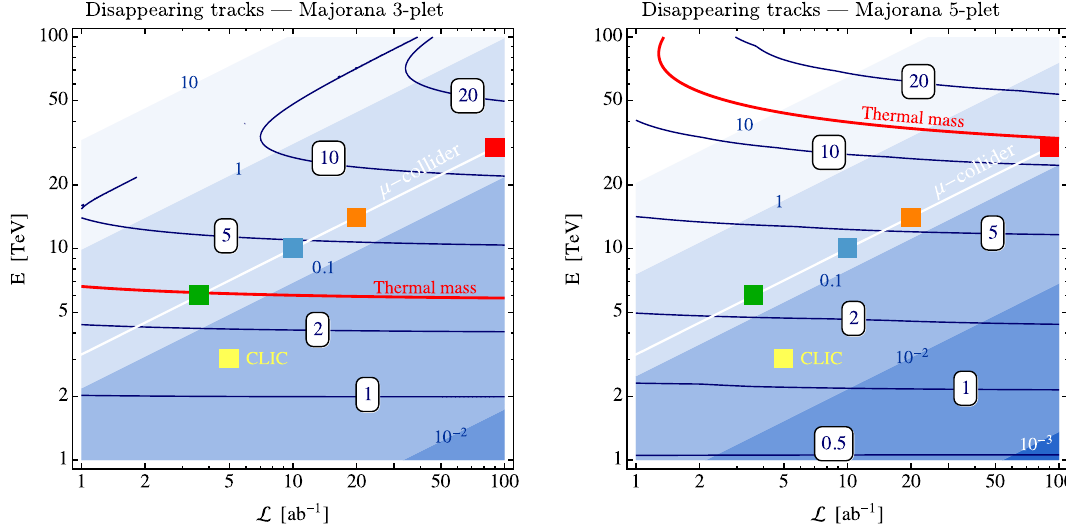
Fig. 6 Same as Fig. 4, but for disappearing track searches in mono- γ events. Left: Majorana 3-plet. Right: Majorana